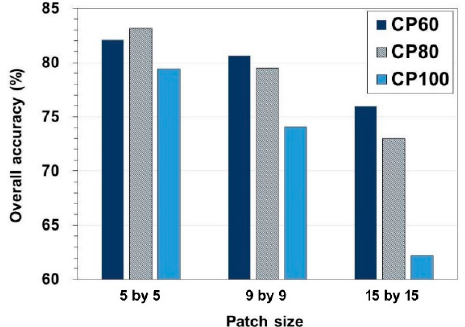
Figure 8. Variations in overall accuracy with respect to three di ff erent patch sizes for di ff erent class purity values in Illinois.